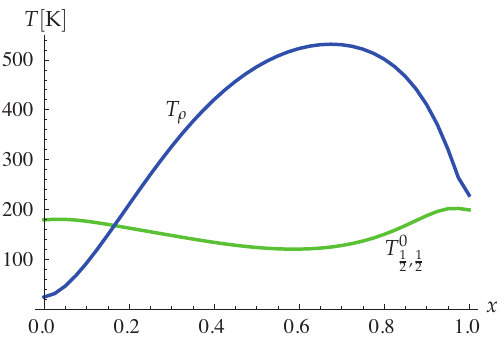
Figure 10. Calculated critical temperature for the ( 1 as a function of TMTTF concentration x in [(TMTSF) 1